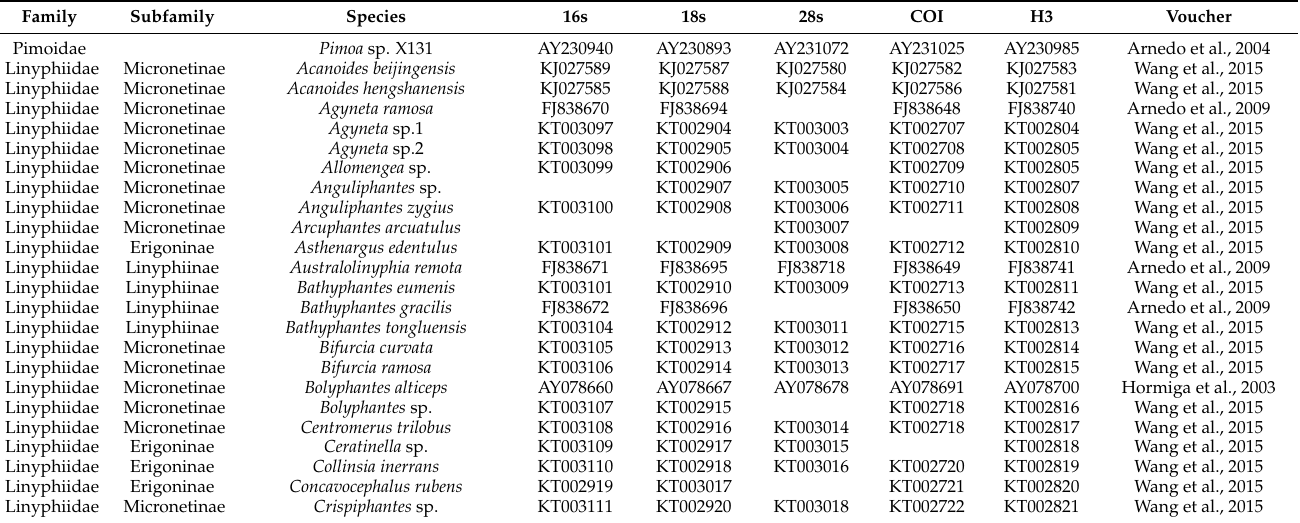
Table 2. Taxon list and sequence information. An asterisk (*) following species names indicate that they are newly sequenced for the present